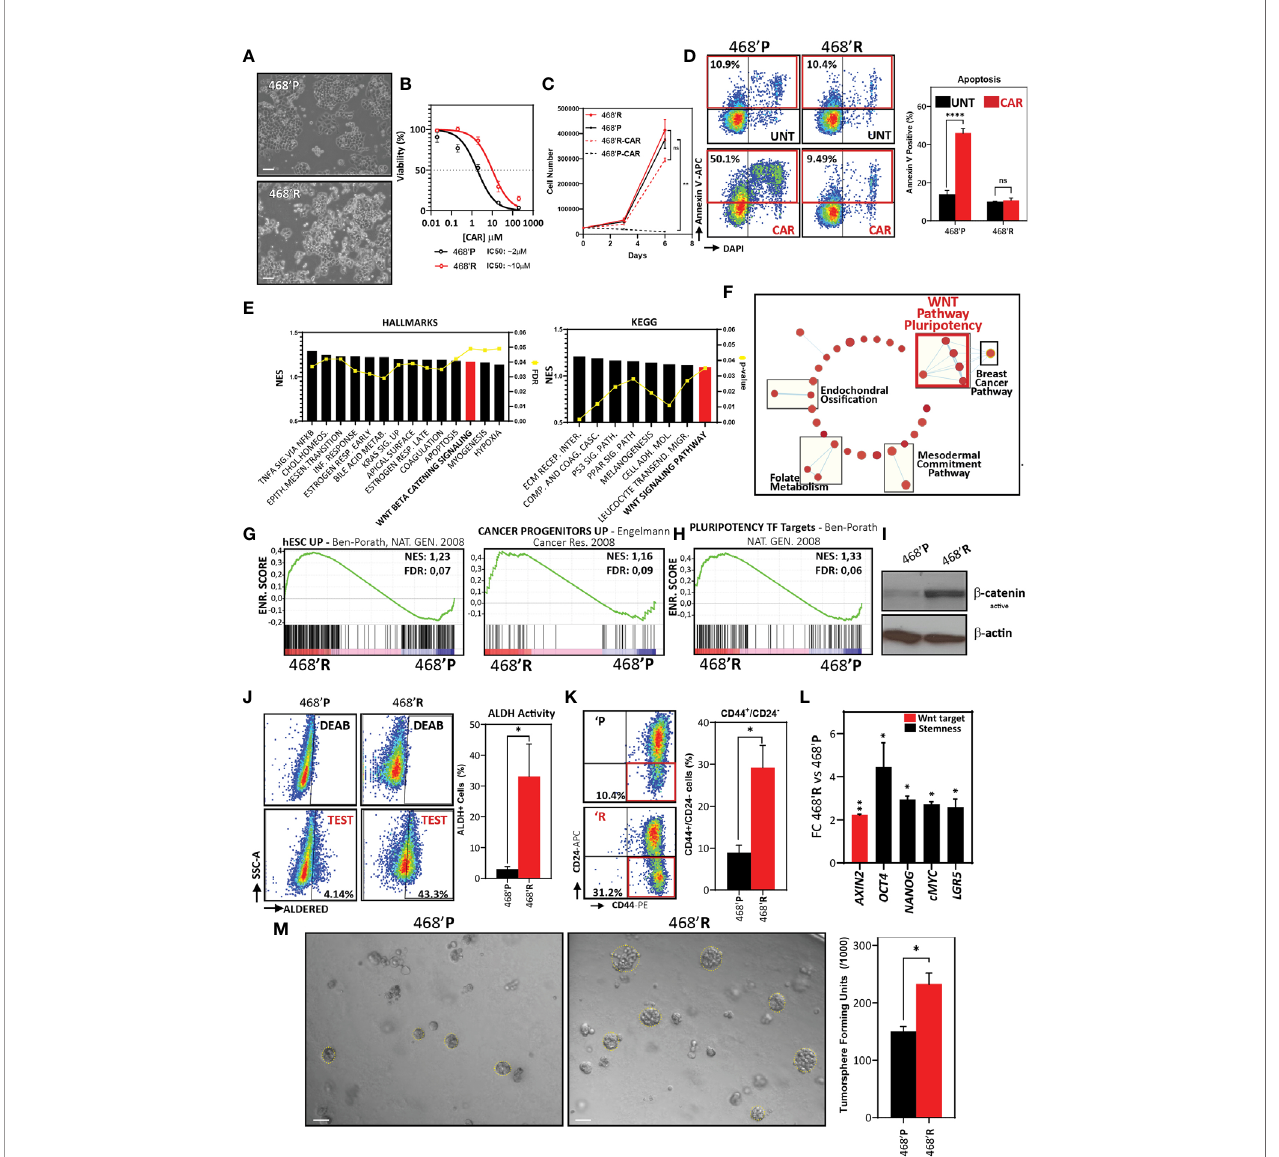
FIGURE 1 | Carboplatin-resistant TNBC cells are characterized by enhanced WNT/ b -catenin pathway activity, stem cell marker expression, and tumorsphere formation capacity . (A) Phase contrast microscope images of 468 ’ P and 468 ’ R cells. Scale bar: 100 m m. (B) Non-linear fi t model of [CAR] m M vs normalized response for IC50 determination. (468 ’ P: n=6, R 2 = 0.92) (468 ’ R: n=4, R 2 = 0.95). (C) Growth curve and statistical analysis for 468 ’ P and 468 ’ R cells treated with VEH or CAR using two-way ANOVA. Statistical signi fi cance is reported for day 6 of treatment (n=4). (D) Representative fl ow cytometry scatterplots of annexin V staining of cells treated with 2 m M CAR for 72 hours (left) and respective statistical analysis (right) using multiple t-tests corrected for multiple comparisons with the Holms-Sidak method (n=3). (E) Enriched gene sets from Hallmarks and KEGG databases by one-tailed GSEA ranked by Normalized enrichment score (NES), illustrating pathways most signi fi cantly deregulated between 468 ’ P and 468 ’ R. (F) Enrichment map of one-tailed GSEA hits from Wikipathways database. Rectangles highlight clusters of gene sets with signi fi cant overlap and are labeled using AutoAnnotate on Cytoscape. (G) GSEA of hESCs (26) (left) and Cancer Progenitor (46) (right) gene sets in 468 ’ R vs 468 ’ P cells. (H) GSEA of NANOG, OCT4, and SOX2 target genes determined by ChIP-SEQ in hESC ’ s (26) in 468 ’ R vs . 468 ’ P cells. (I) Western blot of active non-phosphorylated b -catenin in 468 ’ P and 468 ’ R. b -actin was used as the loading control. (J) Representative scatterplots of fl ow cytometric analysis of aldehyde dehydrogenase activity (left). DEAB panels refer to internal controls in which ALDH activity is blocked with diethylaminobenzaldehyde to determine the background signal generated by unconverted ALDH substrate. TEST panels refer to the experimental samples where substrate for fl uorimetric determination of ALDH activity is supplied. TEST samples are normalized to background fl uorescence measured in DEAB internal controls and presented as the mean + standard error of the mean percentage of ALDH+ cells in 468 ’ R (n=5) and 468 ’ P (n=7) (right). Welch ’ s t-test. (K) Representative scatterplots of fl ow cytometric analysis of CD44-PE and CD24-APC immunolabeling (left) and corresponding statistical analysis of the mean percentage of CD44 +/ CD24 - cells (right; n=3). Welch ’ s t-test. (L) qRT-PCR of Wnt target AXIN2 and stem cell markers in 468 ’ R cells vs . 468 ’ P (n=4). Multiple t-tests. (M) Representative bright fi eld images of tumorspheres generated from 468 ’ P and 468 ’ R cells (left, scale bar: 50 m m) and statistical analysis of mean tumorsphere forming units (number of spheres/number of seeded single cells) (right; n=3). Welch ’ s t-test. (Barplots represent mean + SEM. *p < 0.05; **p < 0.01; ****p < 0.0001; ns, non signi fi